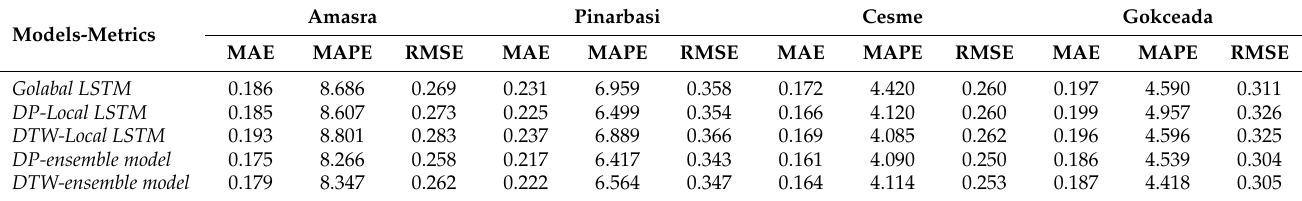
Table 2. The performance of each method for a different test location.